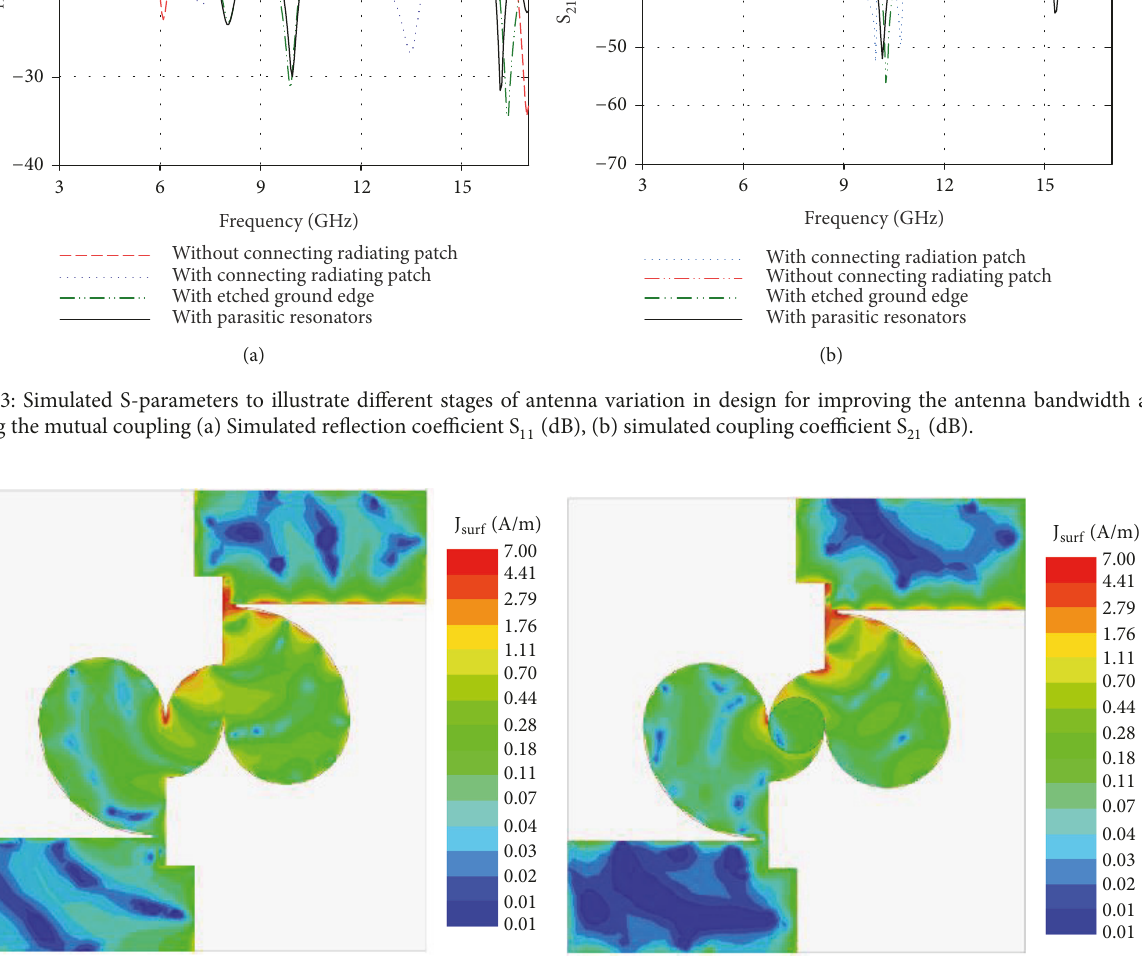
configuration, the mutual coupling between the radiating patch gets reduced